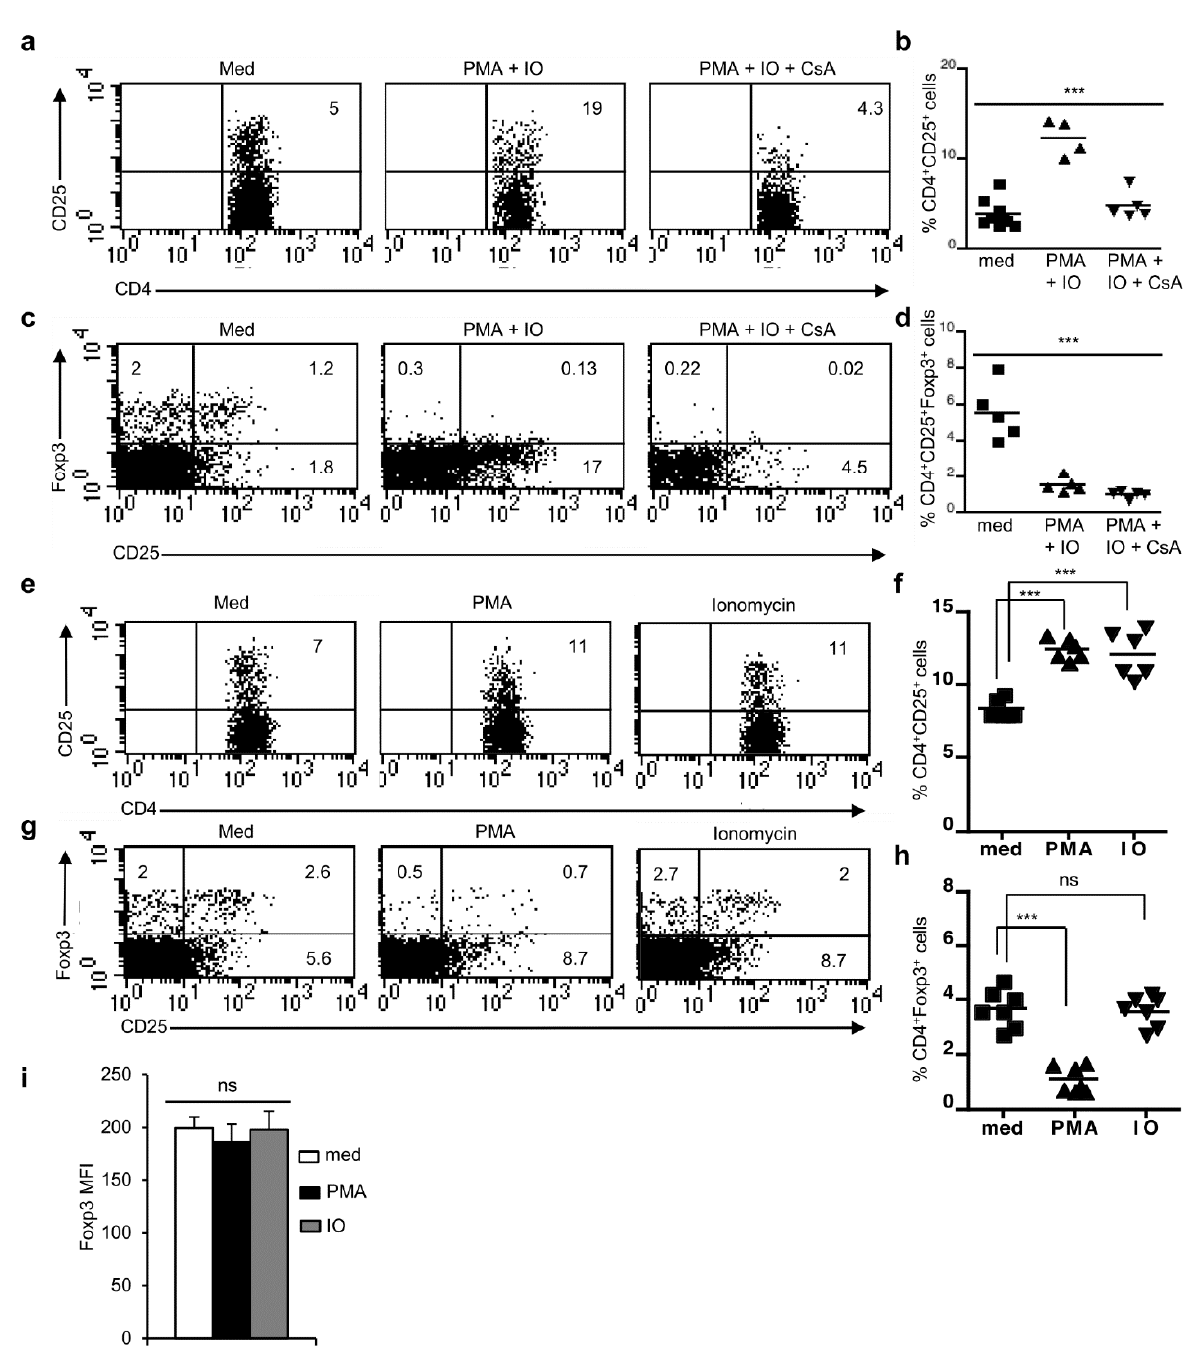
Figure 4. PMA signaling negatively regulates thymic development of Foxp3 + T reg cells. ( a ) Distri- bution of CD4 + CD25 + cells gated on CD4 + T cells in day 3.5 NTOCs from WT mice treated with PMA + Ionomycin (IO) in the presence or absence of CsA. ( b ) Quantification of percent distribution of CD4 + CD25 + cells gated on CD4 + T cells in day 3.5 NTOCs from WT mice treated with PMA + Iono- mycin (IO) in the presence or absence of CsA (*** p < 0.0001; one-way ANOVA). ( c ) Distribution of CD25 + Foxp3 + cells gated on CD4 + T cells in day 3.5 NTOCs from WT mice treated with PMA+Iono- mycin (IO) in the presence or absence of CsA. ( d ) Quantification of percent distribution of CD25 + Foxp3 + cells gated on CD4 + T cells in day 3.5 NTOCs from WT mice treated with PMA + Iono- mycin (IO) in the presence or absence of CsA (*** p < 0.0001; one-way ANOVA). ( e ) Distribution of CD4 + CD25 + cells gated on CD4 + T cells in day 3.5 NTOCs from WT mice treated either with PMA or Ionomycin (IO). ( f ) Quantification of percent distribution of CD4 + CD25 + cells gated on CD4 + T cells